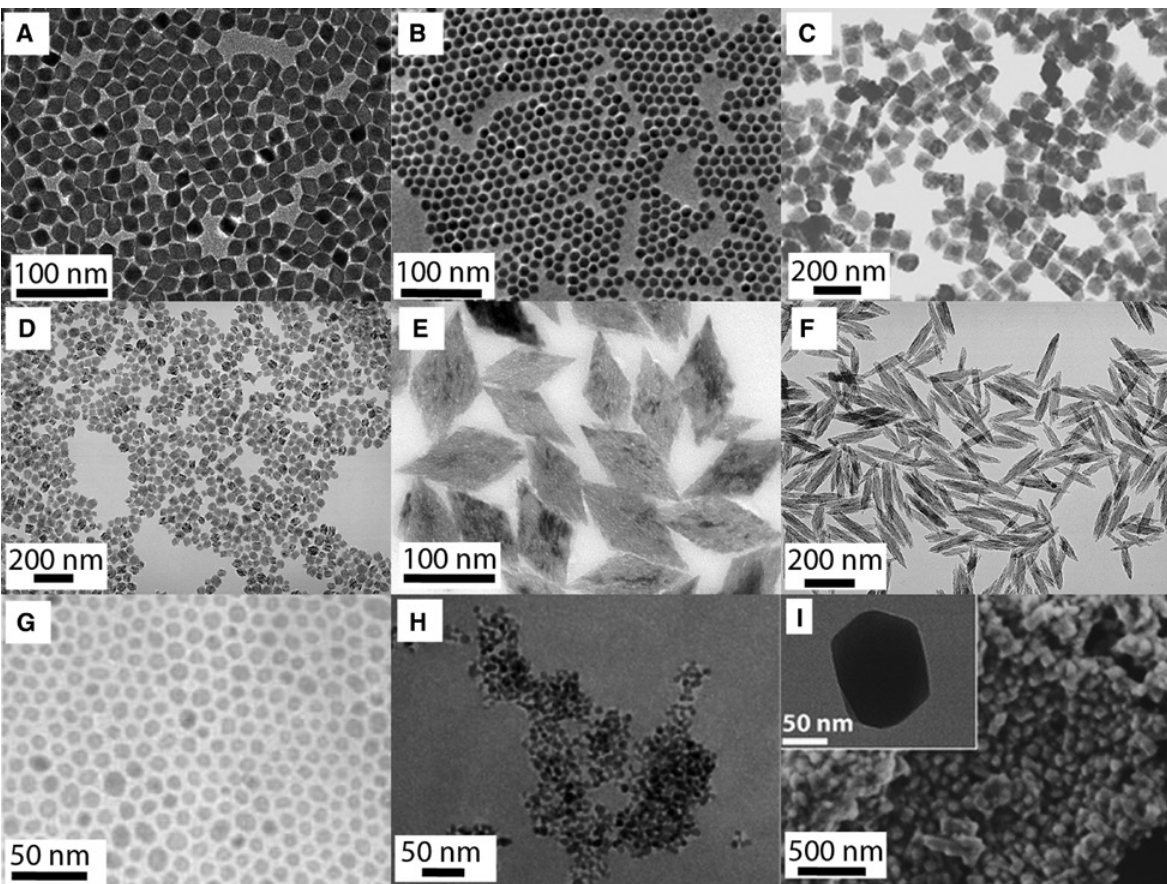
:Nd 3 + NPs synthesized from RE chlorides in ODE/OA at 300 ° C. Taken from [42]. Reproduced with permission of The Royal Figure 1: (A) LiYF 4 Society of Chemistry. Copyright © 2016. (B) α -NaHoF NPs synthesized from RE trifluoroacetates in ODE/OA at 330 ° C. Taken from [13]. 4 Reproduced with permission of the American Chemical Society. Copyright © 2006. (C) GdPO H PO in BG at 120 ° C. Taken from [44]. Reproduced with permission of the American Chemical Society. Copyright © 2013. (D) GdVO 3 4 synthesized from Gd(NO ) and Na VO in an ethylene glycol/water mixture in the presence of PAA at 120 ° C. Taken from [64]. Reproduced 3 3 3 4